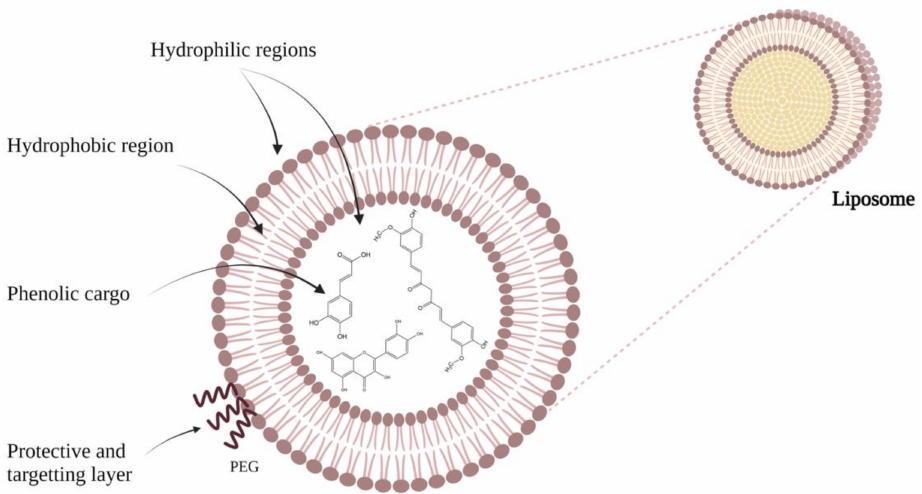
Figure 3. Schematic representation of